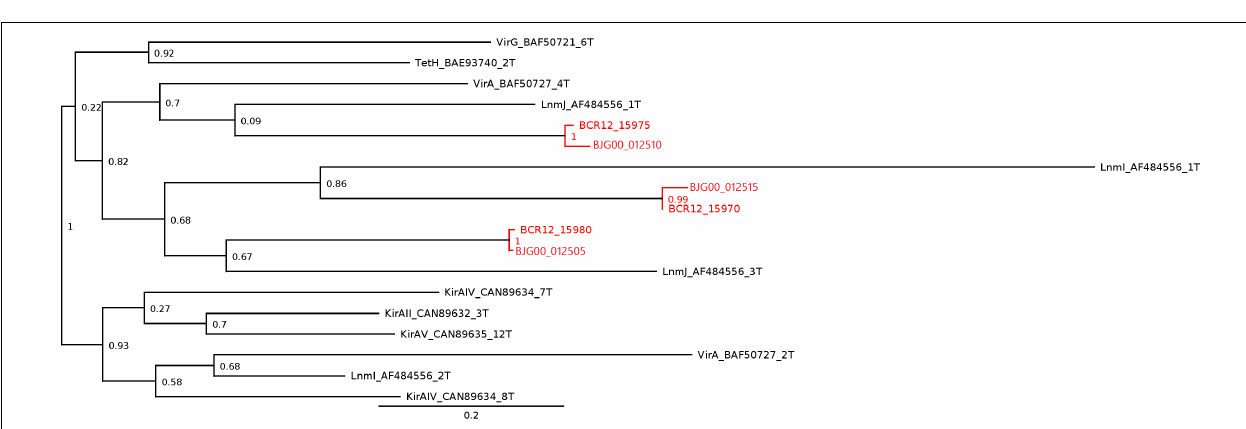
FIGURE 10 | Subtree generated by NaPDoS for Limnothrix sp. CACIAM 69d and Limnothrix sp. P13C2 trans -AT PKS cluster analysis. Limnothrix domain sequences are in red and named based on Table 4 ; the initials BCR12 and BJG00 are, respectively, from Limnothrix sp. P13C2 and Limnothrix sp. CACIAM 69d. Other domain sequences are named according to the NaPDoS database: Vir, virginiamycin; Tet, tetronomycin; Lnm, leinamycin; Kir, kirromycin. The numbers presented are confidence values generated in the NaPDoS tree reconstruction process, which uses the FastTree (Guindon and Gascuel, 2003) to estimate maximum likelihood. The complete tree is available in Supplementary File 3